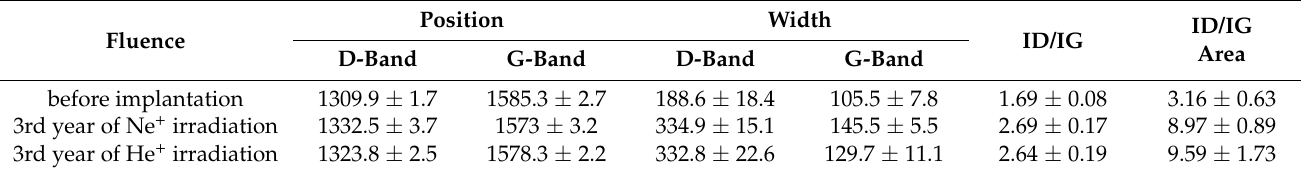
Table 5. S-3 cross-section after irradiation.